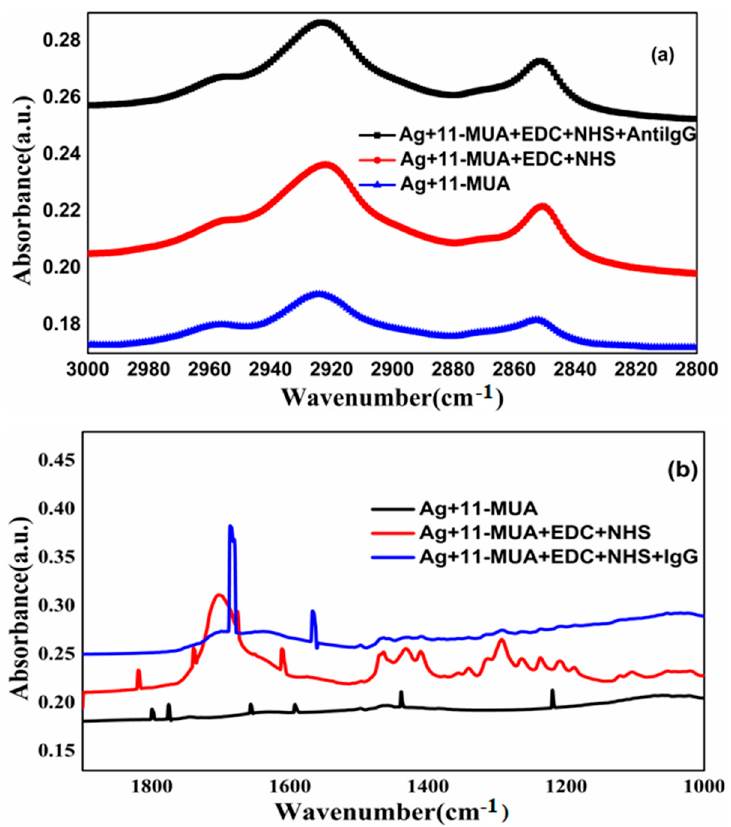
Figure 4. Transform Infrared spectra of the sensor surface before and after the immobilization of antibody: ( a ) absorbance vs wavenumber (2800–3000 cm − 1 ), ( b )absorbance vs wavenumber (1000–1800 cm − 1 ).